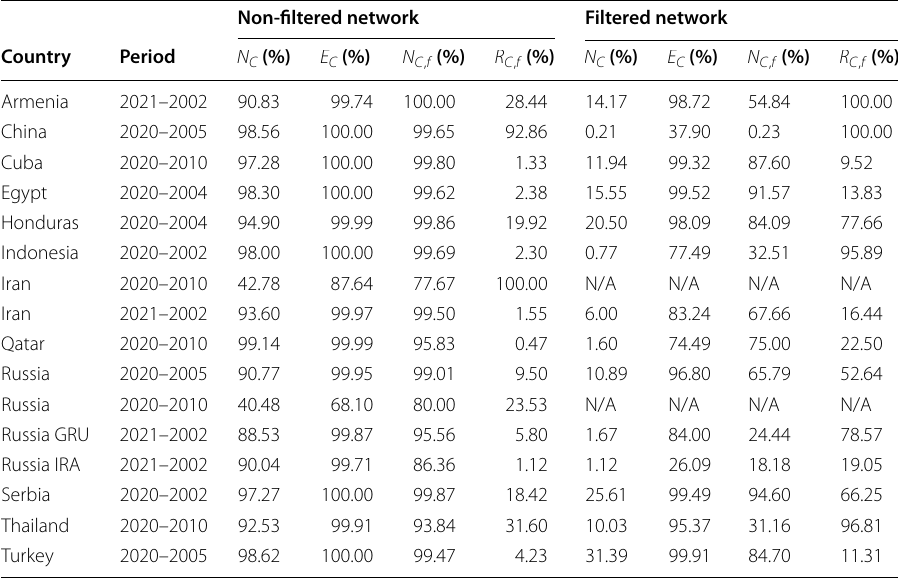
N C denotes the percentage of all nodes that are present in the largest component. E C denotes the percentage of all edges that are present in the largest component. N C , f denotes the percentage of flagged users in the largest component with respect to the total number of flagged users. R C , f denotes the percentage of flagged users with respect to the total number of users in the largest component. A value “N/A” indicates that no significant interactions were found after filtering